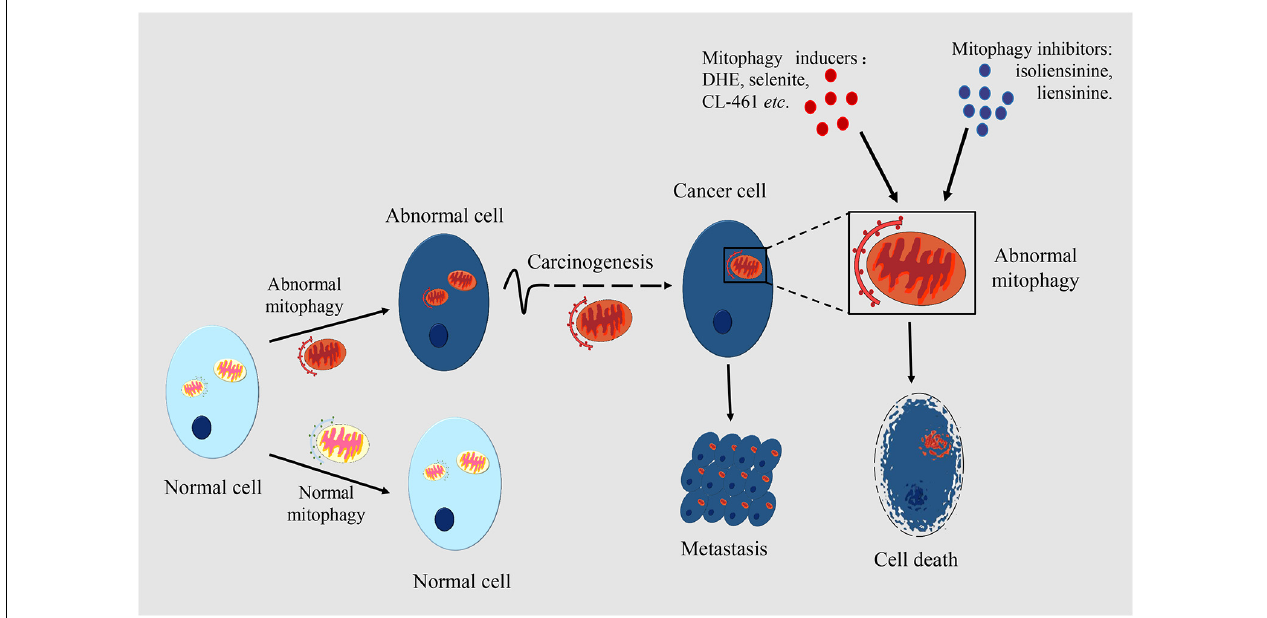
FIGURE 2 | The roles of mitophagy in cancer. Mitophagy occurs in many types of cell. Mitophagic levels are usually enhanced or inhibited in cancer cells, which is different from normal cells. Mitophagy is associated with the occurrence and metastasis of cancers. In certain periods of tumorigenesis, limited mitophagy promotes the development of the tumor, while in established tumors, mitophagy can help the survival of tumor cells. Mitophagy also plays an important role in cancer metastasis. By making mitophagy as the target, inducers or inhibitors of mitophagy can have an anticancer effect through regulating the level of mitophagy. Damaged mitochondria in cancer cells are rapidly cleared through mitophagy which mediates the drug resistance of cancer cells.